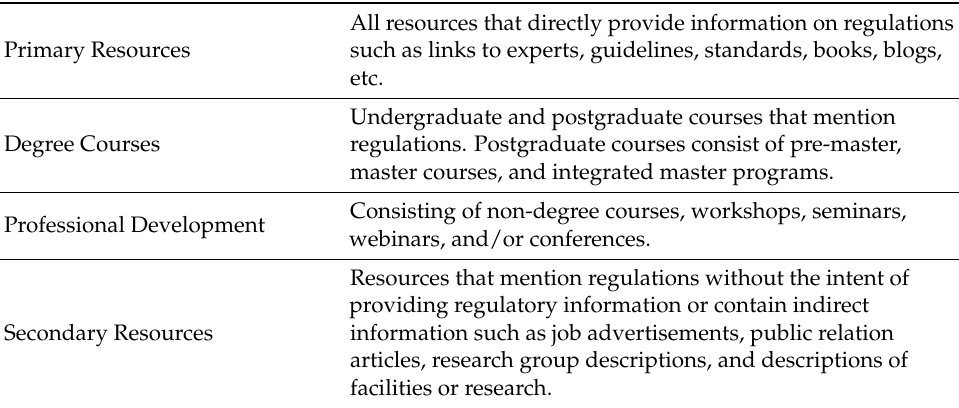
Table 2. Description of content classification mentioning medical device